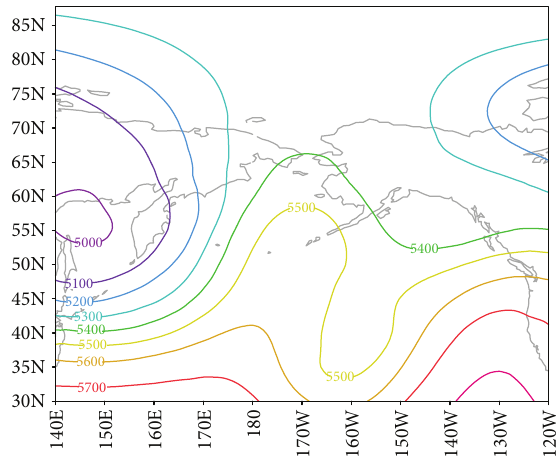
Figure 9: GEFS control time-averaged geopotential heights for March 9–14,